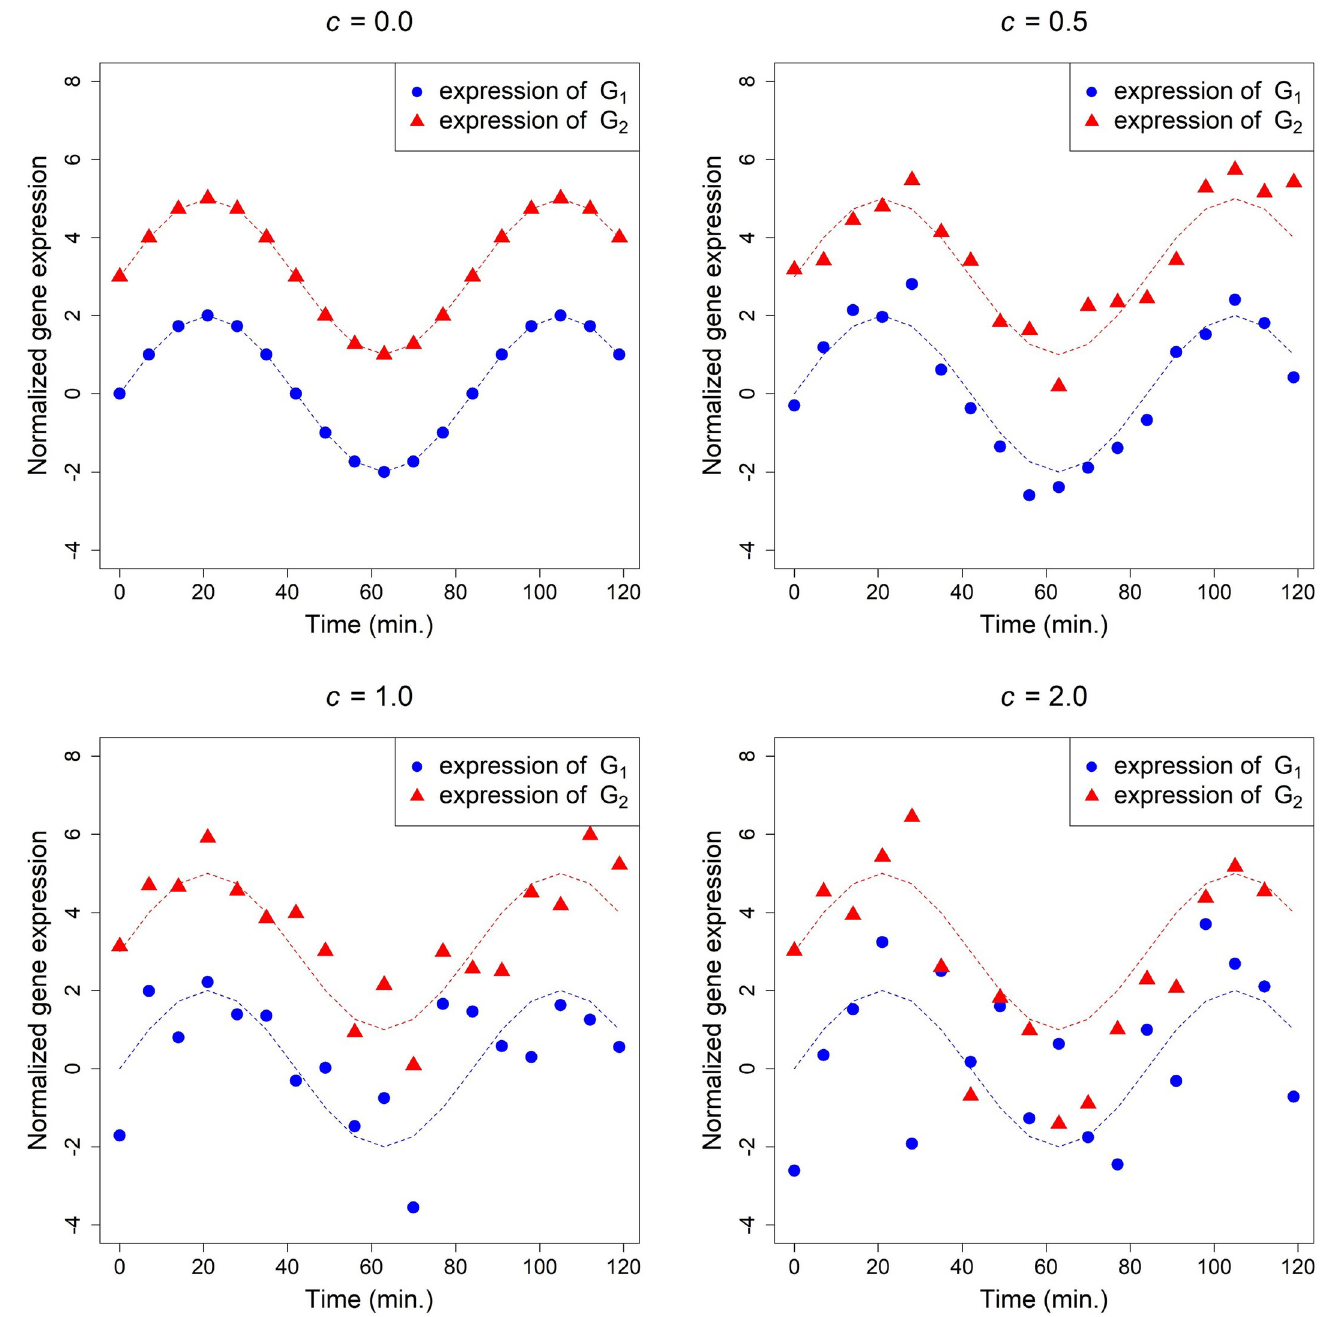
Fig 4. The simulated expression of gene G 1 and G 2 generated by Eqs (5) and (6) with various values of c , where _ ( ▲ ) denotes the values of G 1i ( G 2i ) and i = 0, 1, ... , 17. https://doi.org/10.1371/journal.pone.0270270.g004 correlation and dCor on the estimation of the nonlinear correlation in Case 3. And similar to Case 1 and 2, K with polynomial kernels and Kendall’s correlation are not suitable estimators, c due to high FPRs and small and insignificant coefficients, respectively, when noise is low to moderate in data.